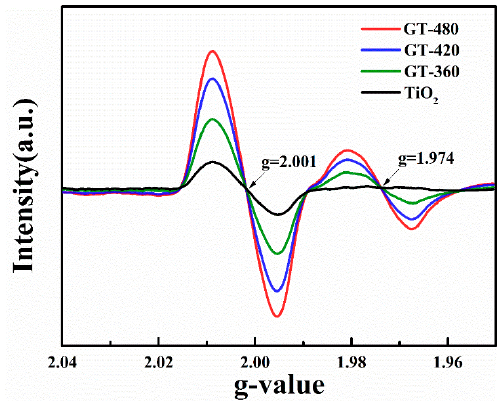
Figure 8. EPR(Electron paramagnetic resonance) spectra of the as-synthesized gray TiO 2 − x samples obtained with di ff erent plasma discharge